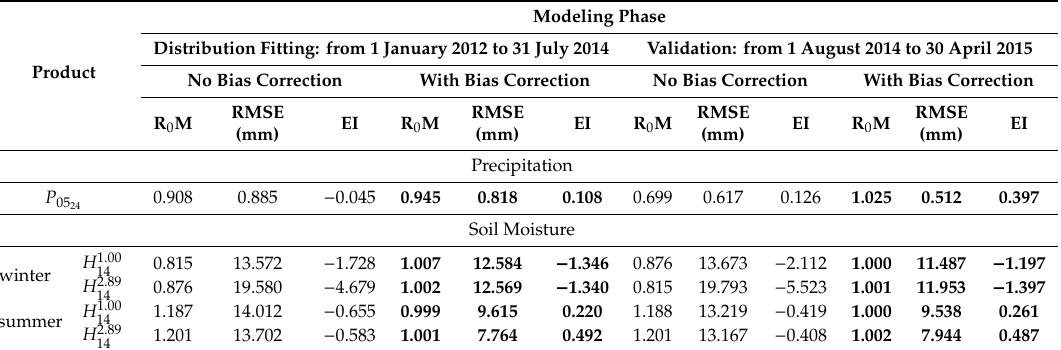
Table 2. Improvement in the modeling accuracy of the P OBS and θ HBV with BC of precipitation and soil moisture H-SAF products: P 05 , H 1.00 and H 2.89 , based on the R 0 M (ratio of means), RMSE (root 14 14 24 mean squared error), and EI (Nash-Sutcli ff e e ffi ciency index). Bold values show the improved accuracy of modeling H-SAF products after